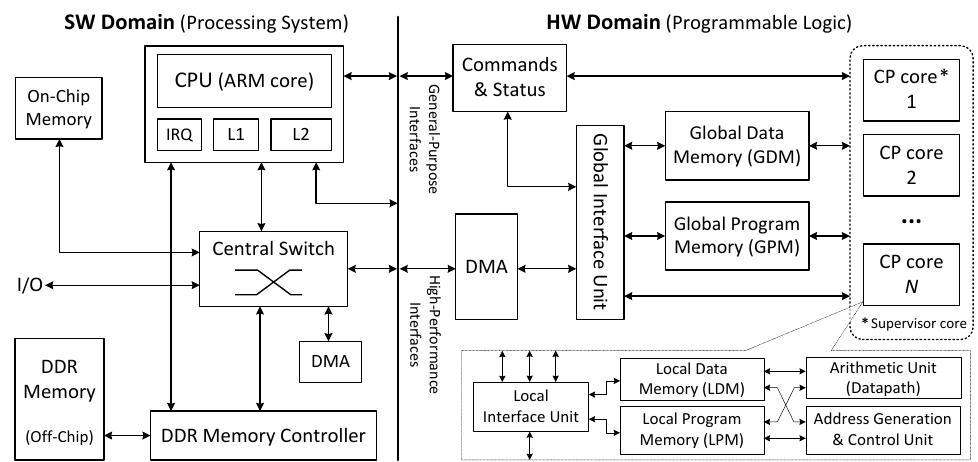
Figure 1: High level architecture of the programmable HW/SW codesign